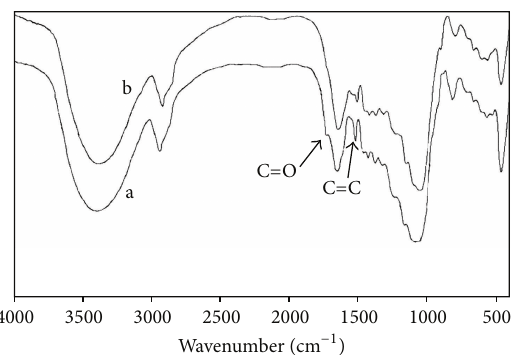
Figure 2: FT-IR spectrum of (a) untreated RHF and (b) NaOH- treated RHF in 72 hours.